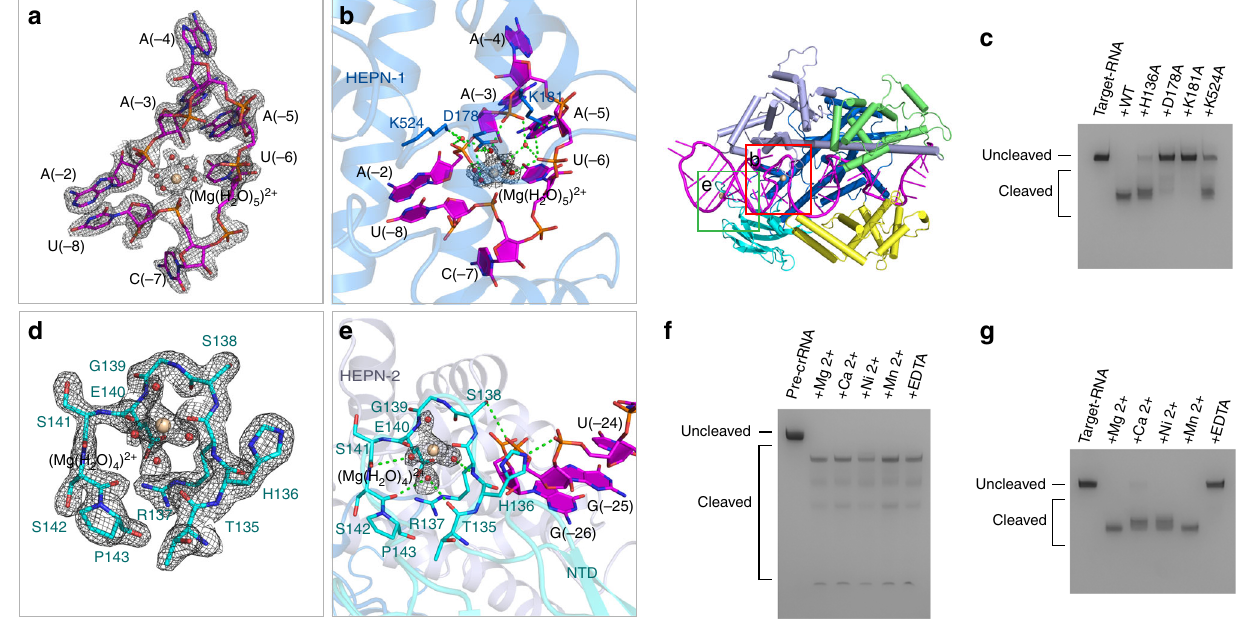
Fig. 2 Hydrated Mg 2 + ions aid in stabilizing the crRNA repeat region. a The electron density map of the penta-hydrated Mg 2 + ion and its surrounding nucleotides in the crRNA repeat region. The 2Fo-Fc omit map was contoured at 1.0 σ level. b Details of the interactions between the penta-hydrated Mg 2 + ion and its surrounding nucleotides, residues in the binary complex. Hydrogen bonds are shown as dashed lines. Domains, residues and crRNA are colored according to Fig. 1. c Denaturing gel demonstrating the cleavage of target RNA by wild-type UrCas13d and the mutants in complex with crRNA. d The electron density map of the tetra-hydrated Mg 2 + ion and its surrounding residues of UrCas13d. The 2Fo-Fc omit map was contoured at 1.0 σ level. e Details of the interactions between the tetra-hydrated Mg 2 + ion and its surrounding residues, nucleotides in the binary complex. f Denaturing gel demonstrating pre-crRNA cleavage by wild-type UrCas13d in the presence of different divalent metal ions or EDTA. g Denaturing gel demonstrating the cleavage of target RNA by wild-type UrCas13d in complex with crRNA and in the presence of different divalent metal ions or